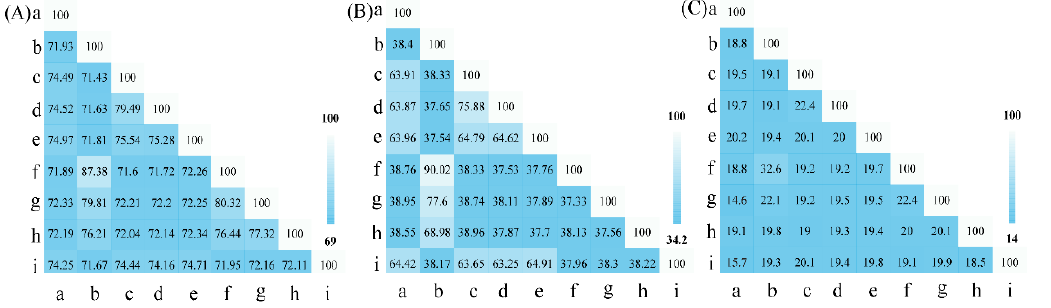
Figure 6. Genome comparisons of strains S5-59 T , S8-45 T , and their related reference strains including the OrthoANI value ( A ), AAI value ( B ), and dDDH value ( C ). Further, a–h represent S5-59 T , S8-45 T , Sphingomonas panacisoli HKS19 T , Sphingomonas asaccharolytica NBRC 15499 T , Sphingomonas panacis DCY99 T , Sphingomonas kaistensis PB56 T , Sphingomonas astaxanthinifaciens DSM 22298 T , and Sphingomonas ginsengisoli KCTC 12630 T , respectively. Additionally, i was the type species of Sphingomonas , i.e., Sphingomonas paucimobilis DSM 1098 T .